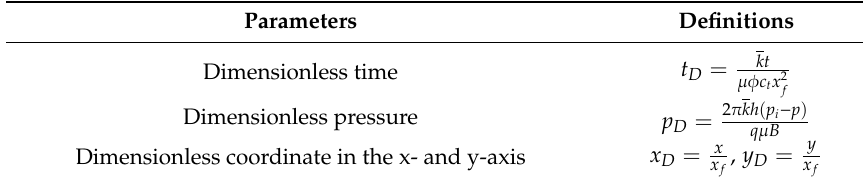
Table 1. Dimensionless variables.